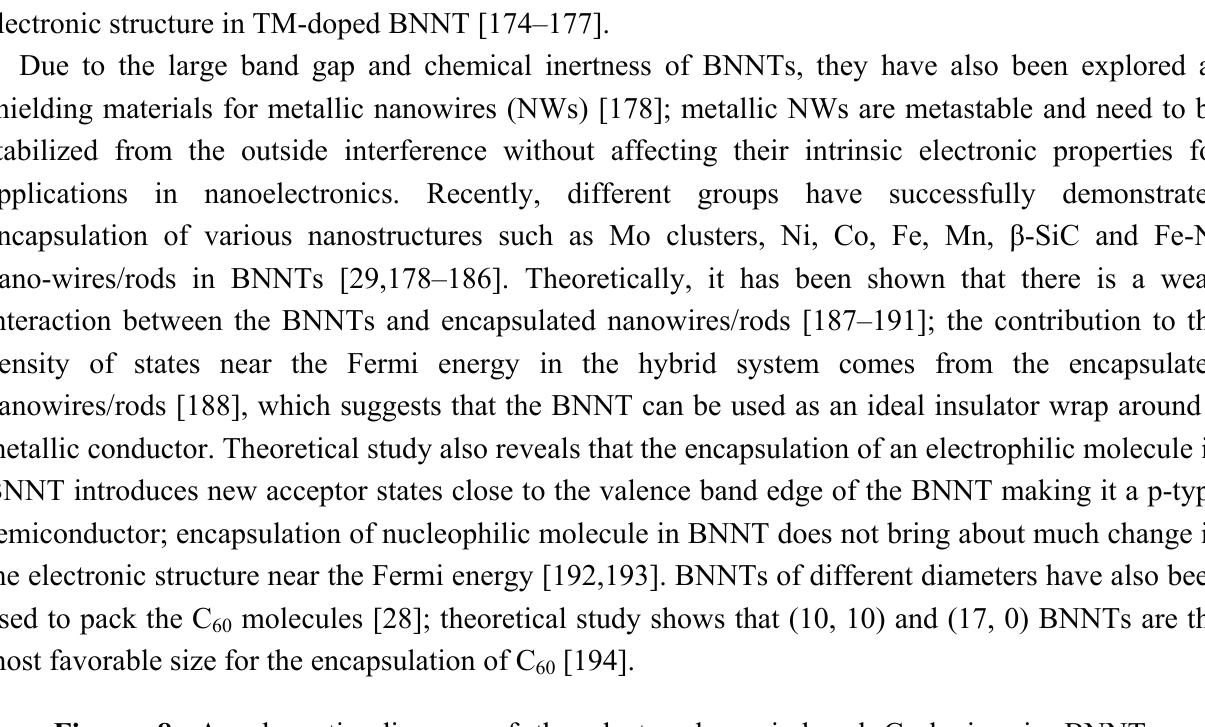
Figure 8. A schematic diagram of the electron-beam-induced C doping in BNNT. Reprinted with permission from [27]; © 2010 American Chemical